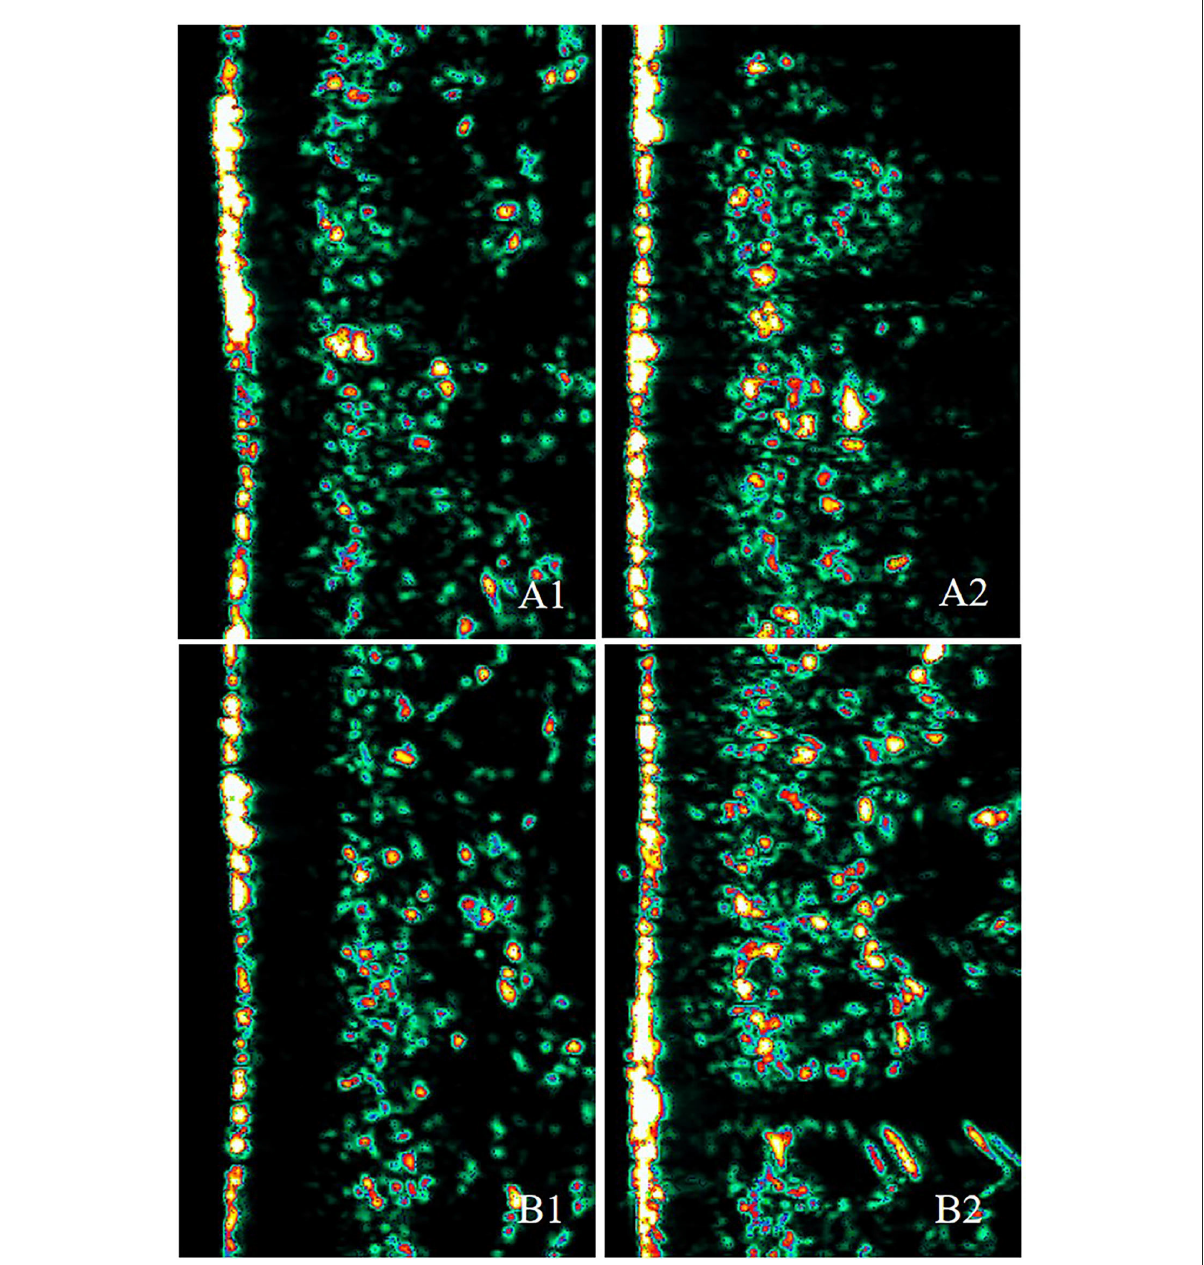
FIGURE6 Ultrasound images of a 40-year-old woman at the baseline and at 2 weeks after the last treatment. A1 and B1 show images taken at the baseline (A1: skin elasticity = 5.3, skin thickness = 1,290.3 µ m; B1: skin elasticity = 5.3, skin thickness = 1,158.7 µ m). A2 shows the image taken 2 weeks after the last ECM-C via MN treatment (skin elasticity = 5.6, skin thickness = 1,422 µ m). B2 represents the image taken 2 weeks after the last ECM-C via MN and RF treatment (skin elasticity = 6.1, skin thickness = 1,457 µ m). Echogenicity color scale: white > yellow > red > green > black.